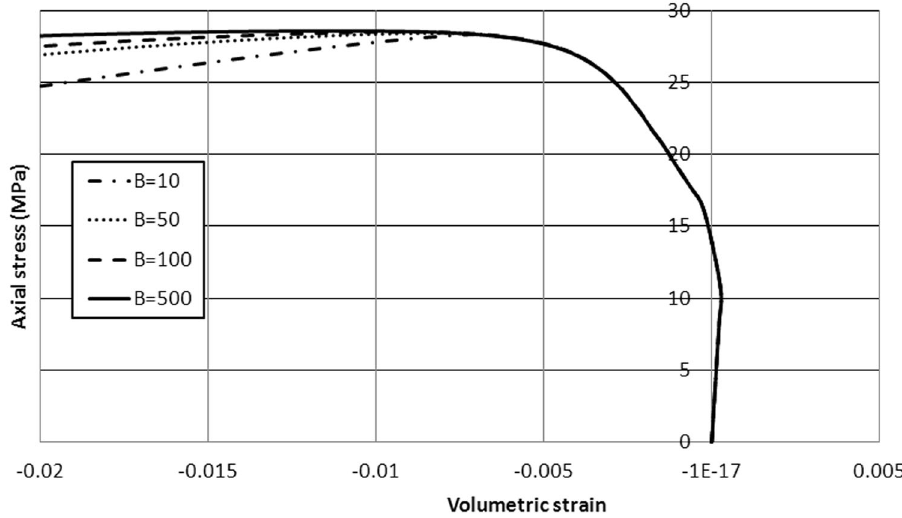
Fig. 4 Compaction to extension behavior of CSCM.